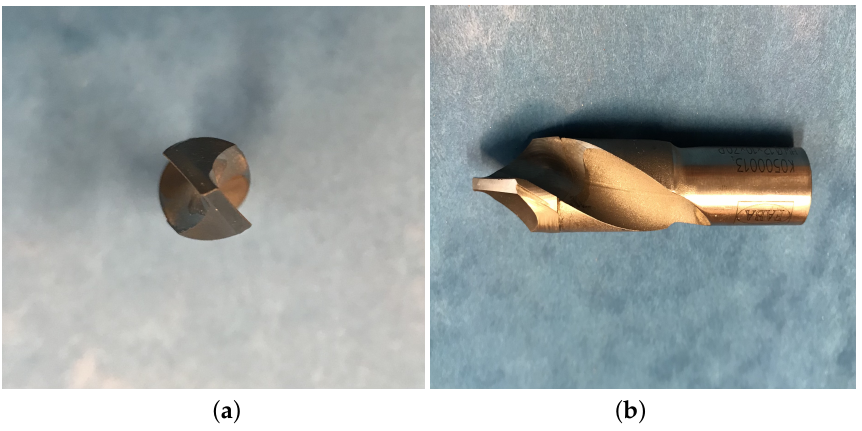
Figure 1. The FABA WP-01 drill used during experiments: top ( a ) and left ( b ) view.